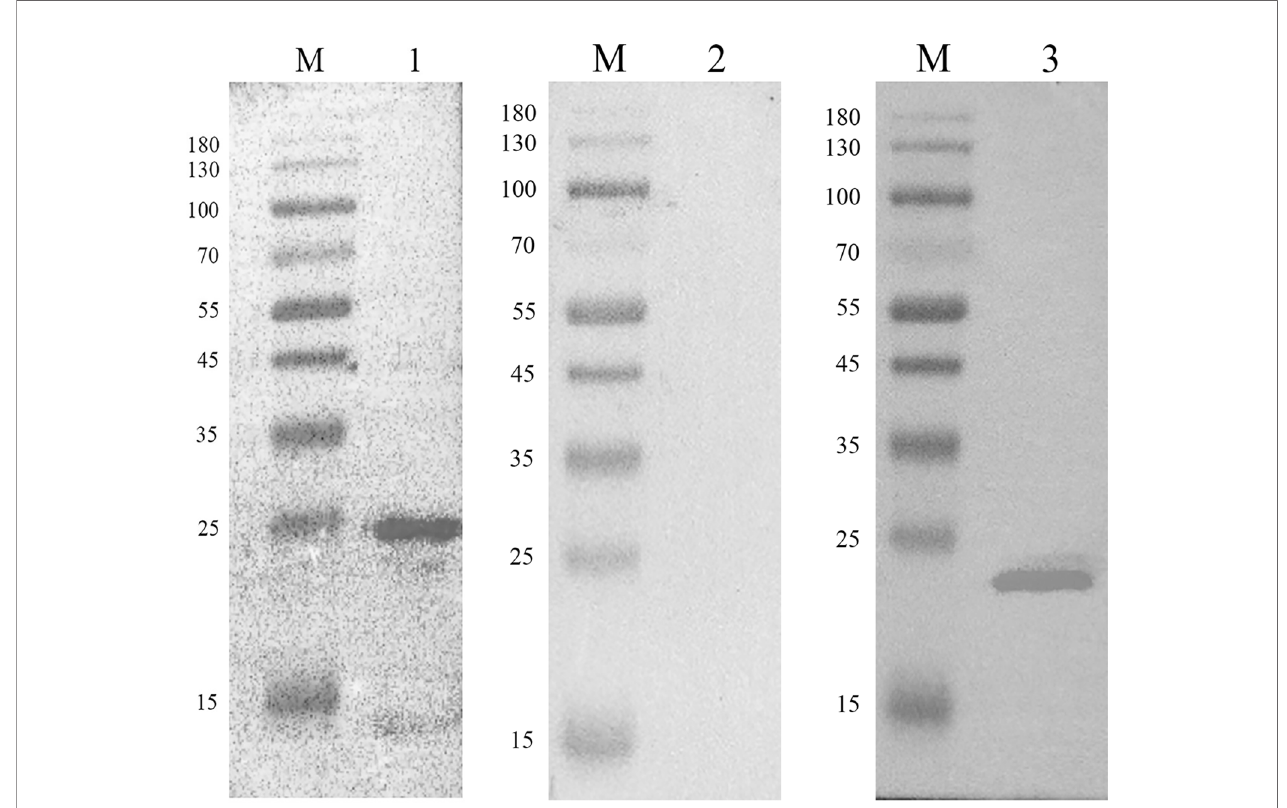
FIGURE 2 | Immunoblot analysis of recombinant protein pET-28a-EmARM- b Western blot analysis of recombinant protein pET-28a-EmARM- b . M: protein mid- molecular weight marker. Lane 1: The recognition of recombinant protein pET-28a-EmARM- b by the chicken serum against E. maxima . Lane 2: The recognition of recombinant protein pET-28a-EmARM- b by negative chicken serum. Lane 3: The recognition of His-Tag in recombinant protein pET-28a-EmARM- b by His-tag Mouse Monoclonal